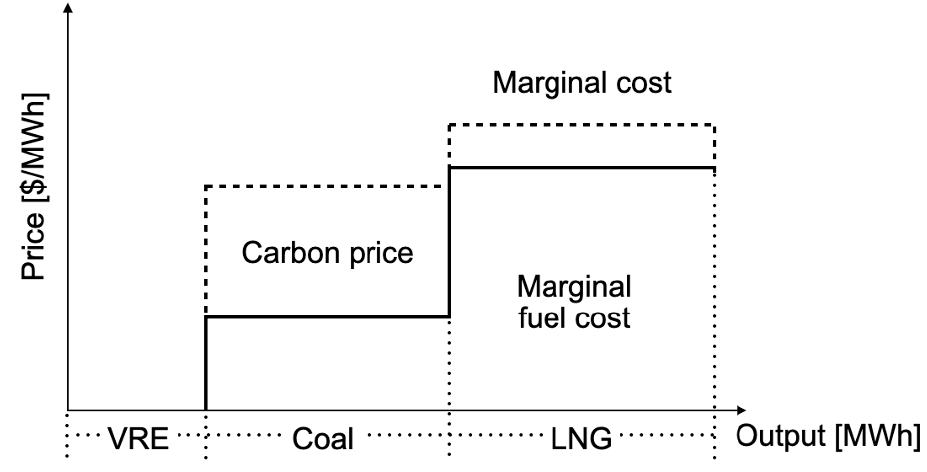
Figure 4. Concept of merit-order electricity pricing.